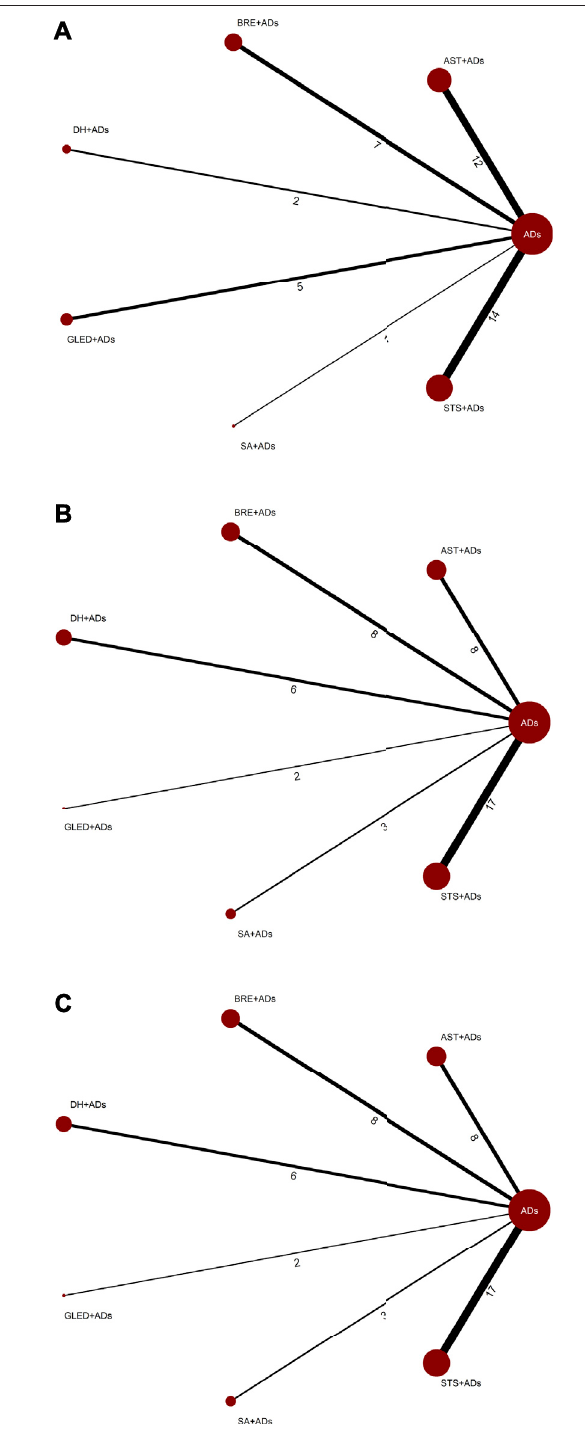
FIGURE 2 | Network plots for primary outcomes. ADs: antihypertensive drugs; SA: salvianolate; DH: danhong; BRE: breviscapine; AST: astragalus; STS: sodium tanshinone IIA sulfonate; GLED: ginkgo leaf extract and dipyridamole. (A) : 24-h urinary protein excretion; (B) : Systolic blood pressure; (C) : Diastolic blood pressure.